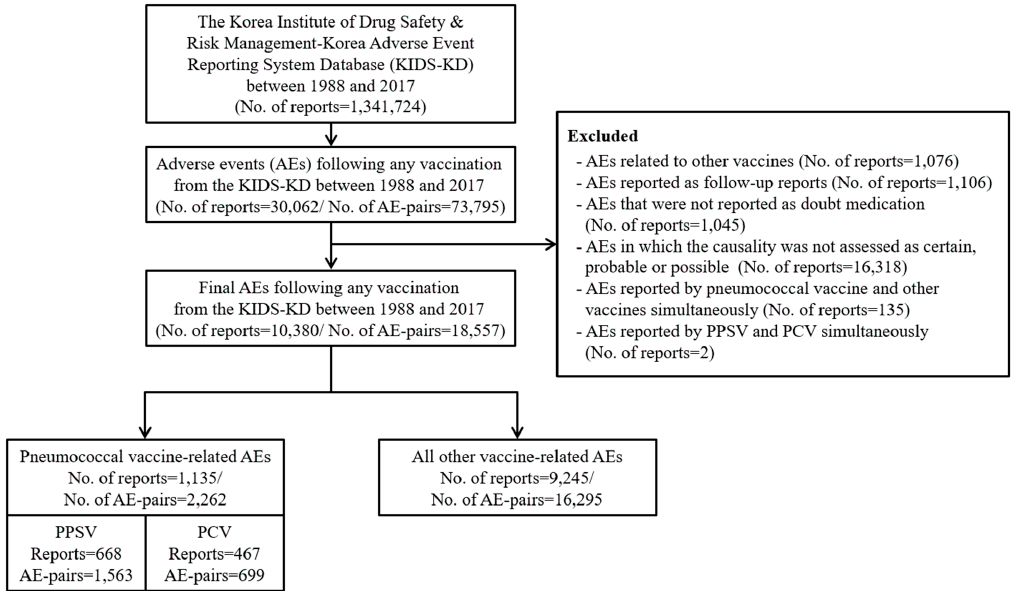
Figure 1. Flowchart of selection for adverse event reports. Abbreviations: PPSV, pneumococcal polysaccharide vaccine; PCV, pneumococcal conjugate vaccine.